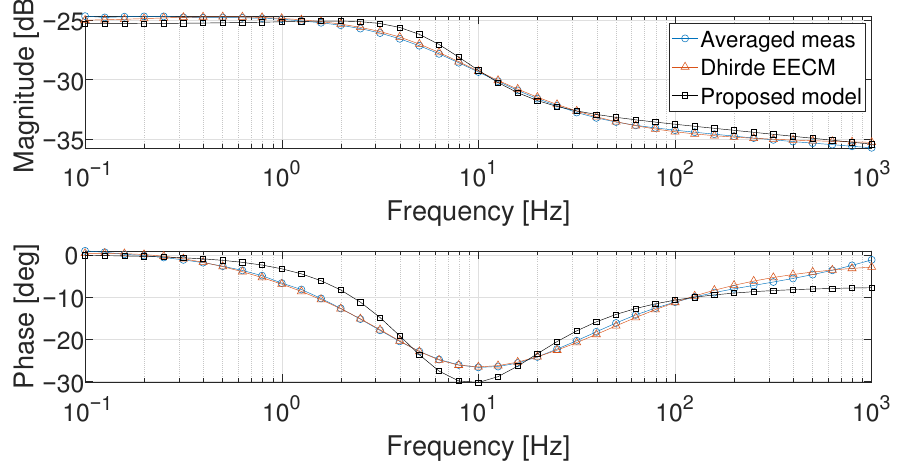
Figure 25. Bode diagram of the averaged measurement (circle marked), the Dhirde et al. model (triangle marked), and the proposed model of (8) (squared marked) at 1A.